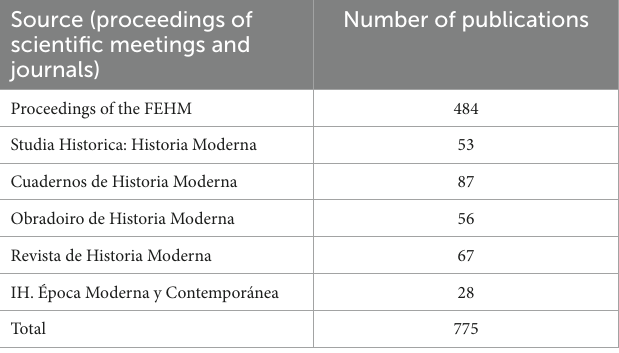
TABLE 2 Publications on the Early Modern Age analysed in the proceedings of the FEHM and in five prestigious journals. Source (proceedings of scientific meetings and